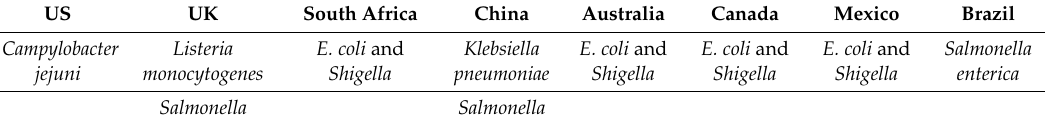
Table 4. Foodborne pathogens with an increasing occurrence in the eight selected countries